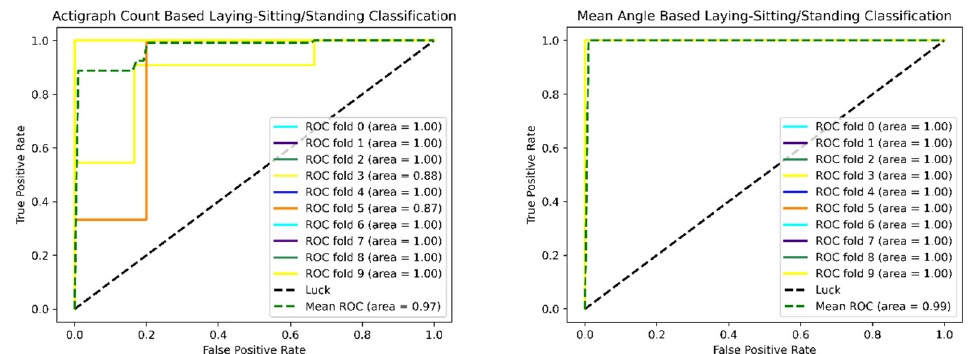
Figure 10. ROC curve for laying and other static classification. The left panel denotes the ROC curve for the Actigraph count-based laying and other static classification. The right panel denotes the mean angle-based static and dynamic activities’ classification.